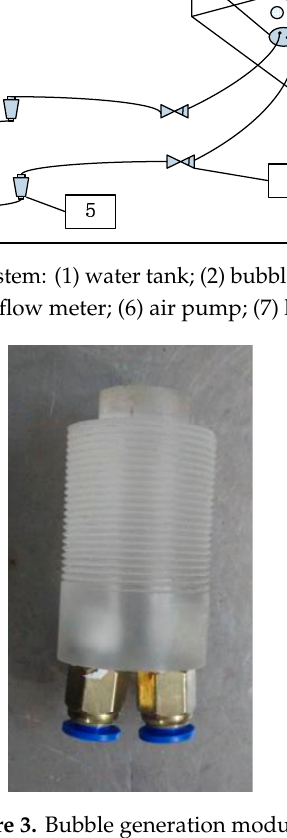
Figure 3. Bubble generation module.